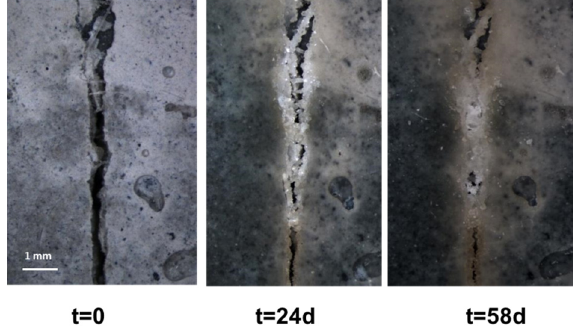
Figure 2. Self ‐ healing of an 0.8 ‐ mm wide crack in concrete at a dosage of 15 kg of self ‐ healing agent per m 3 takes up to two months